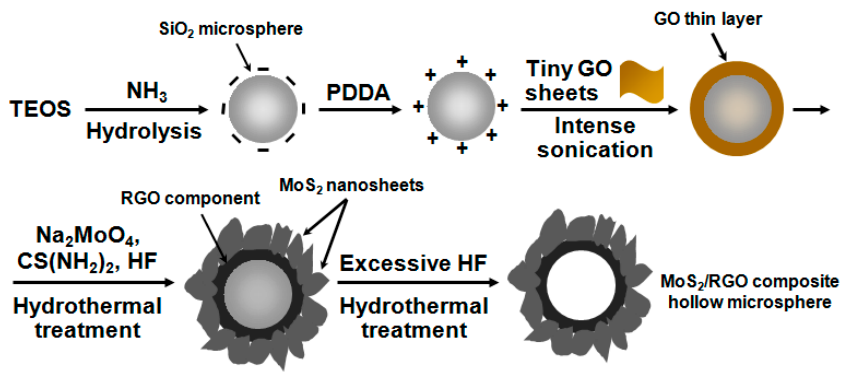
Figure 1. Schematic illustration of the preparation of MoS 2 /RGO composite hollow microspheres.